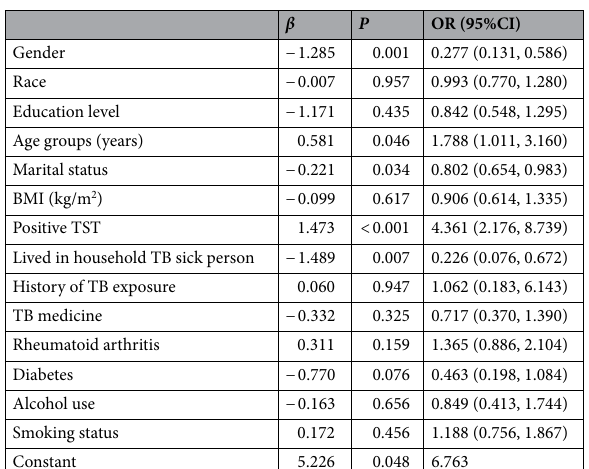
Table 5. Correlation of clinical variables with QFT-GIT results. Related details about these variables can be found in the Table 1.